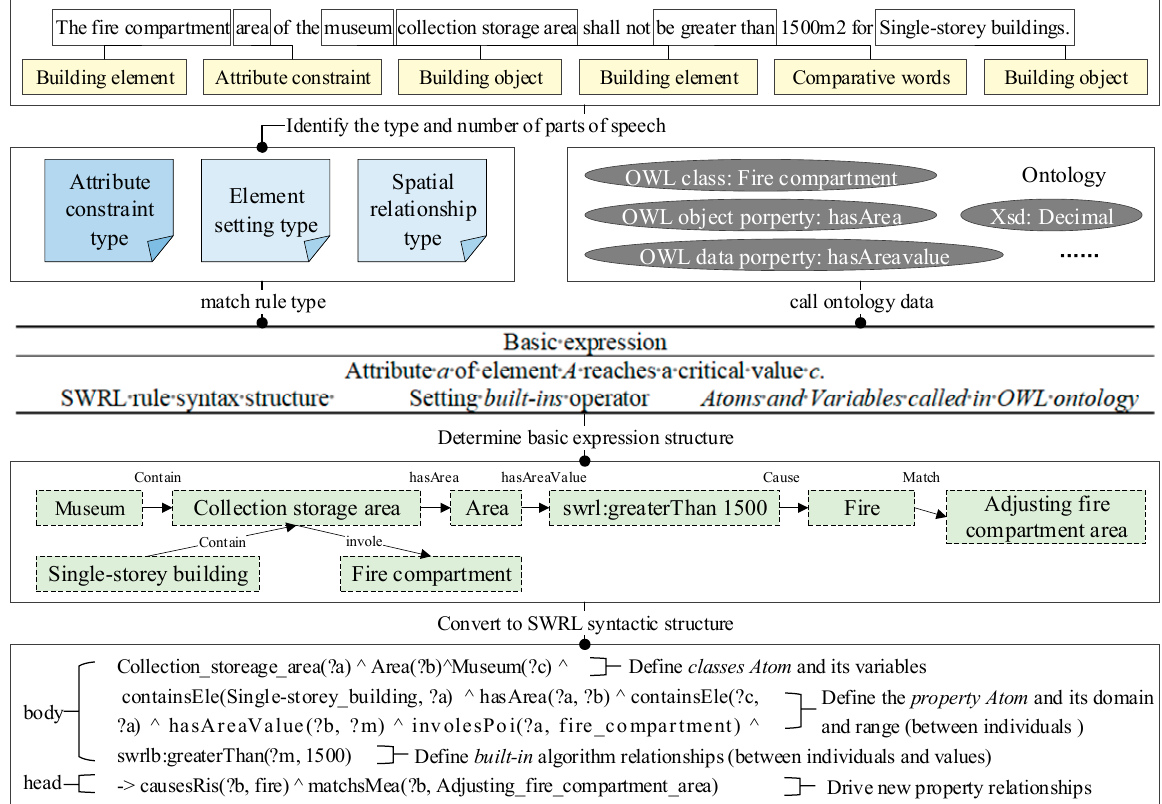
Figure 9. Transforming safety regulations expressed in natural language into structured language.